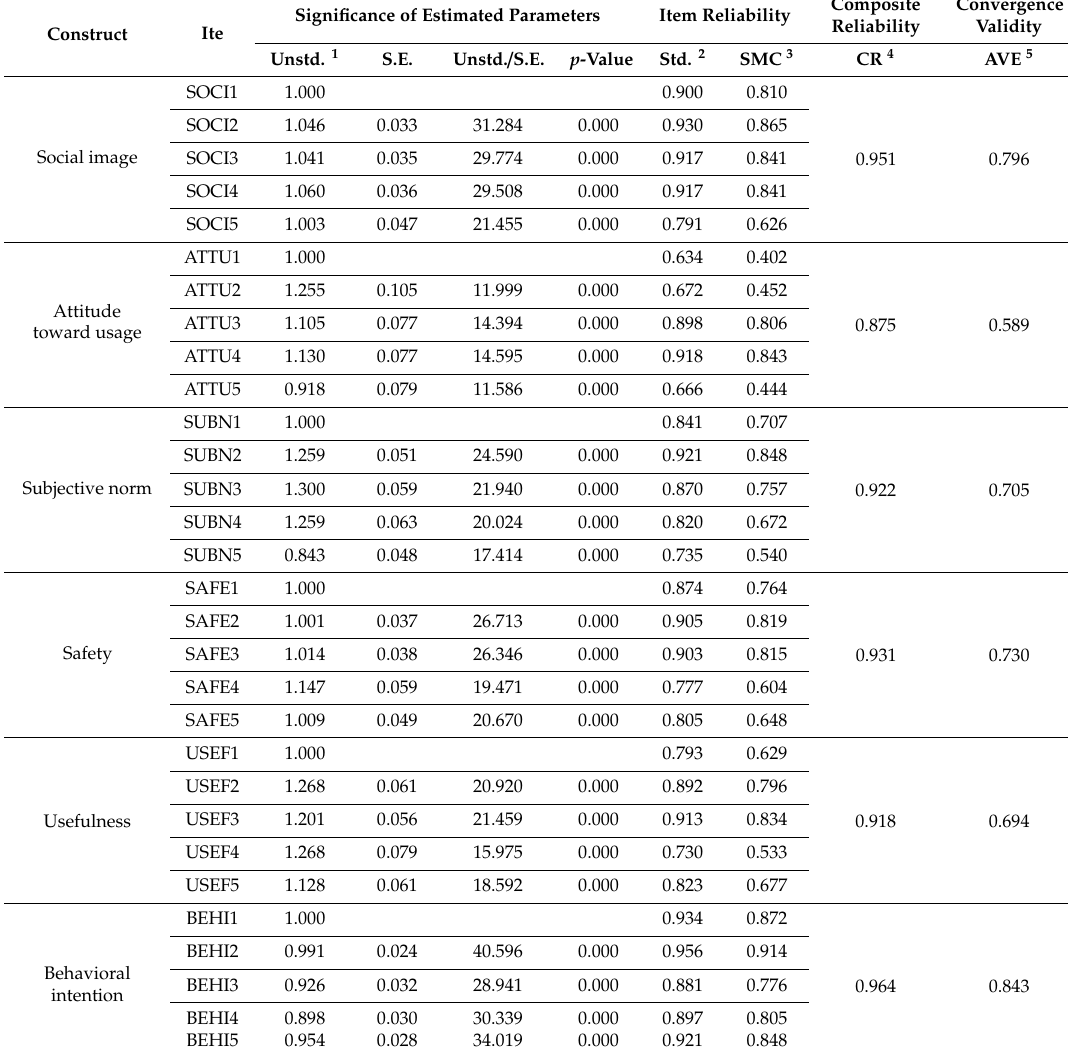
Table 4. Confirmatory factor